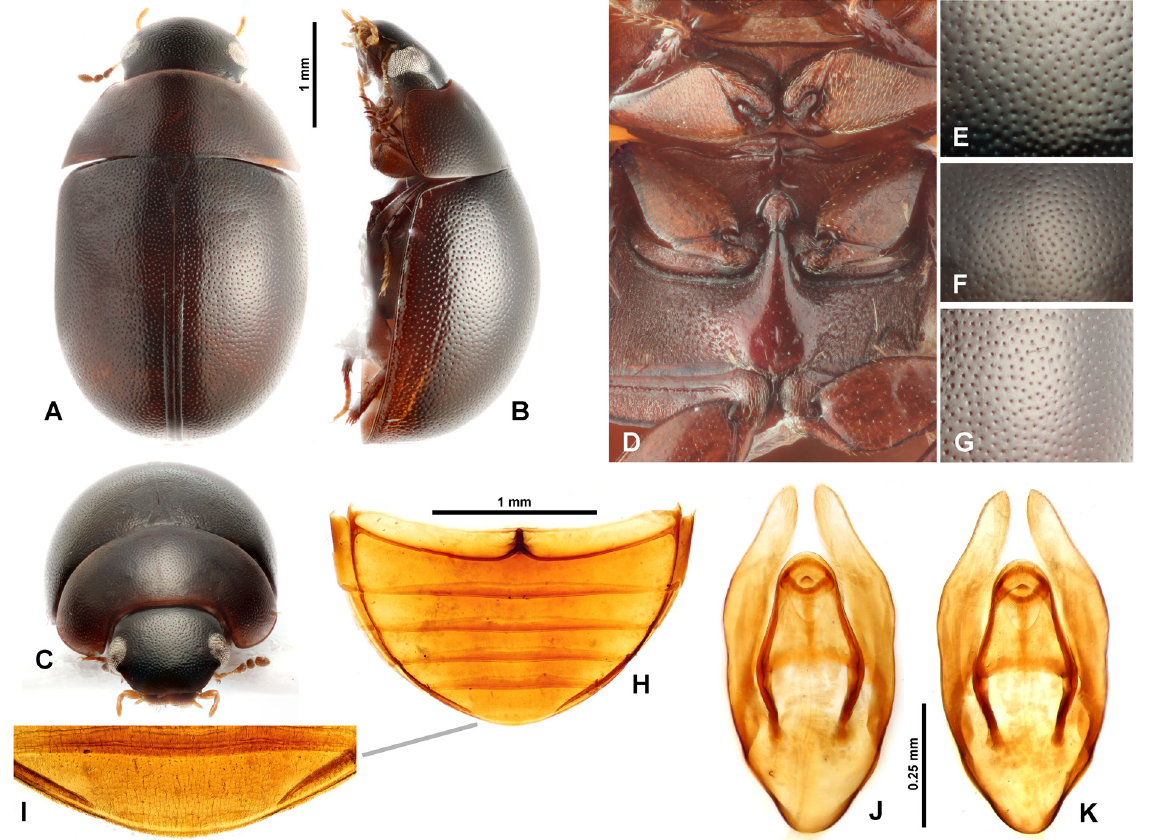
Fig. 5. Coelostoma (s. str.) nostocinum sp. nov. A . Dorsal habitus. B . Lateral habitus. C . Frontal